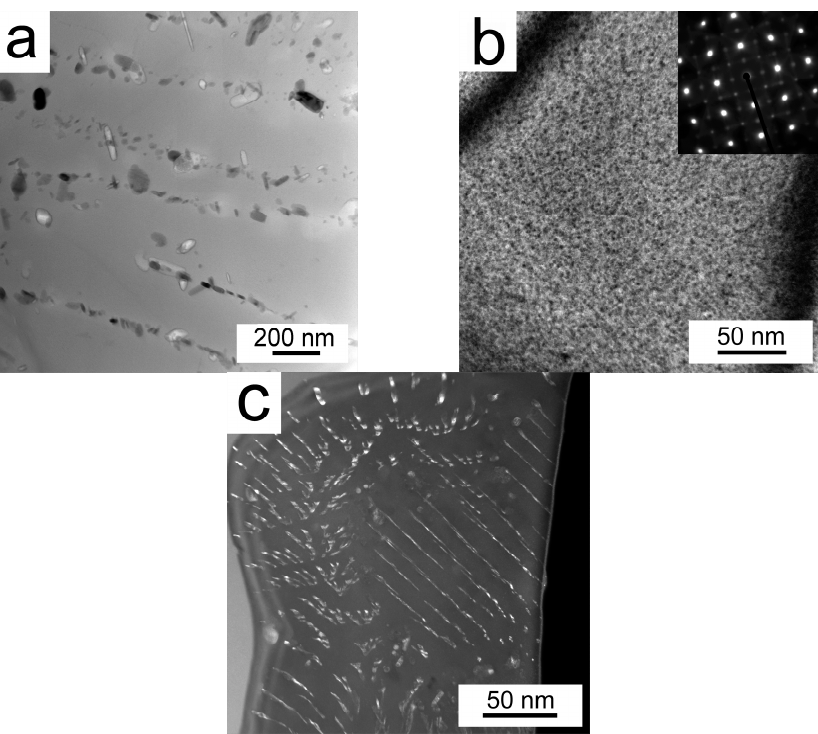
Figure 16. The microstructure of the Al7075Zr_AC compact: ( a ) precipitates arranged into chains; ( b ) homogeneous distribution of nm-sized Al 3 Zr; ( c ) Al 3 Zr particles arranged into a fan-shaped structure in dark field contrast mode, TEM.